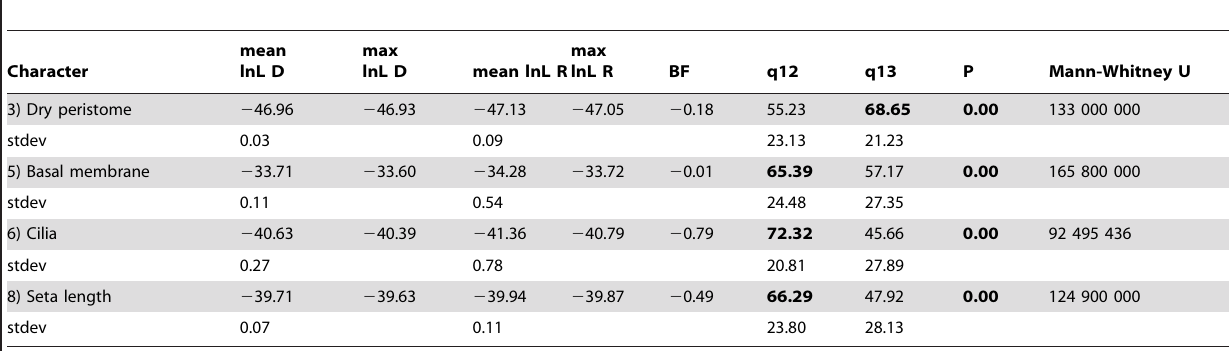
Table 3. Comparisons between rates of dual character state change in morphology and